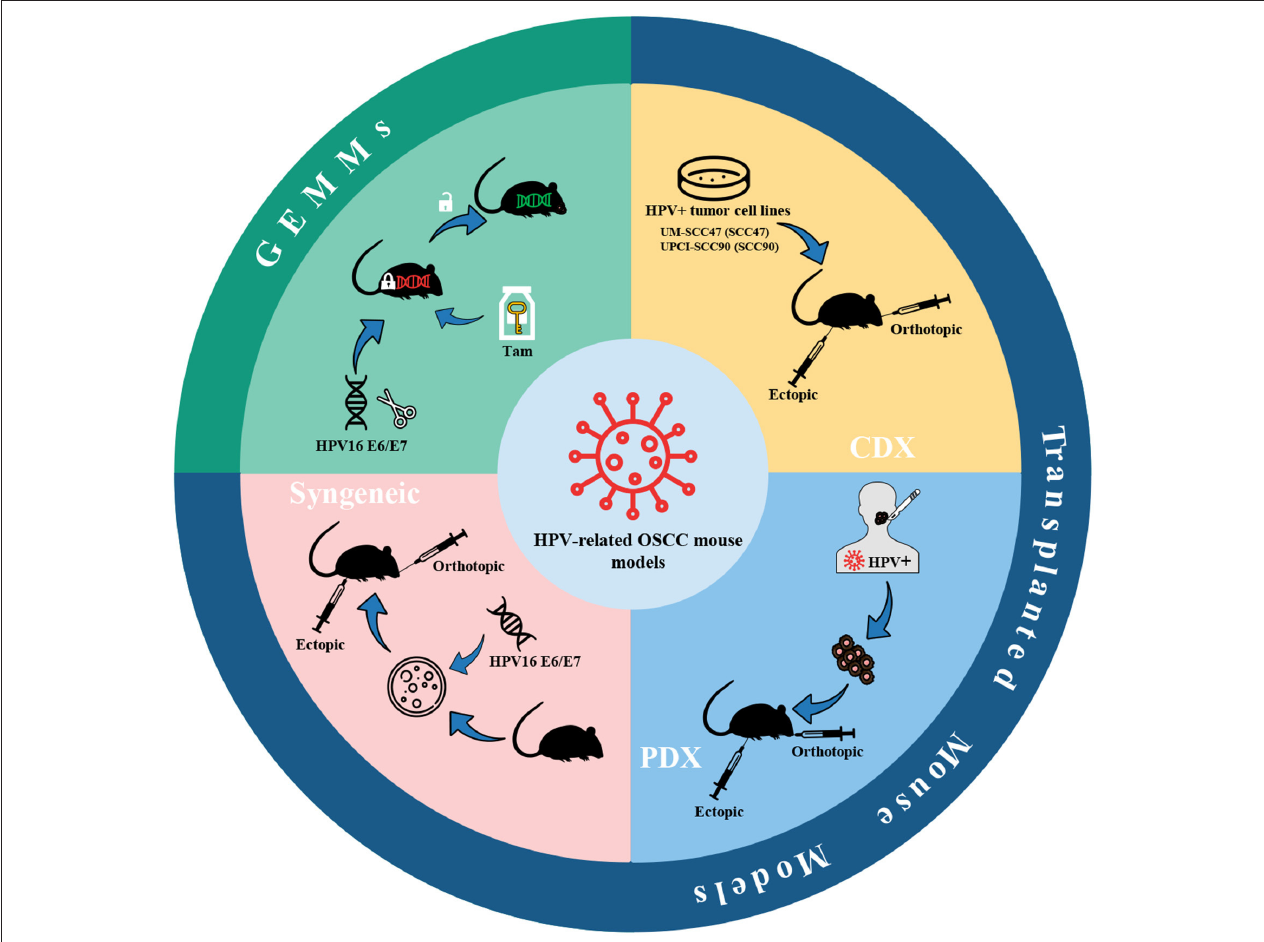
FIGURE 6 | HPV-related OSCC mouse models. Mouse models of HPV-positive oral cancer can be generated by injecting HPV-positive HNSCC cell lines (CDX) or transplanting tumor fragments from HPV-positive HNSCC patients (PDX) or engrafting syngeneic HPV-positive cell lines, e.g., HPV16 E6/E7-expressing MTECs. Also, conditional GEMMs can be utilized to establish HPV-related OSCC mouse models. Adhesions: HPV, human papillomavirus; CDX, cell-derived xenograft; PDX, patient-derived xenograft; MTECs, mouse tonsil epithelial cells; GEMMs, genetically engineered models; Tam,